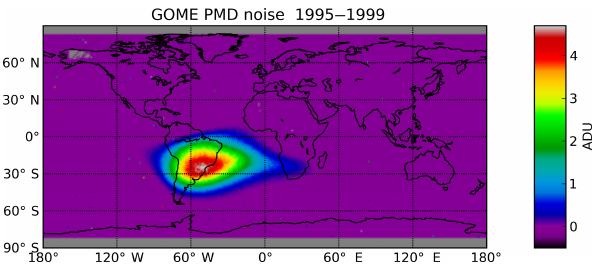
Figure 17. Map of the GOME long-term mean PMD 1 noise in A/D(-converter) units ( = binary units) derived from the first 5 years of the mission. Enhanced noise levels indicate measurements af- fected by the South Atlantic Anomaly.